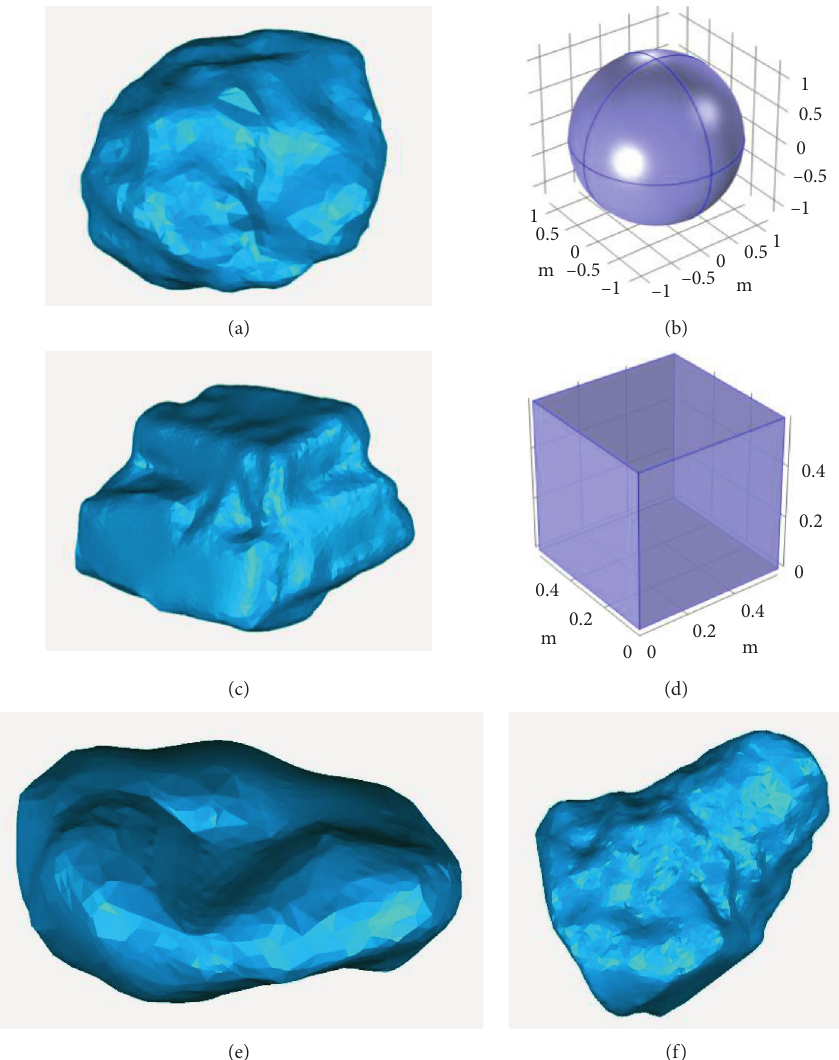
Figure 10: Simplified cavity shape and irregular cavity model. (a) Sphere-like. (b) Sphere. (c) Cube-like. (d) Cube. (e) Irregular cave model I. (f) Irregular cave model